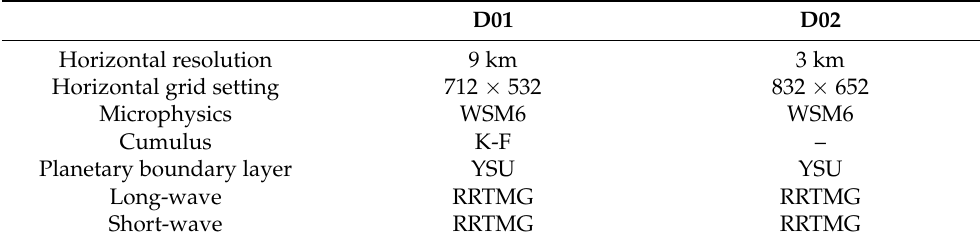
Table 1. Grids and detailed parameterization schemes of simulation.